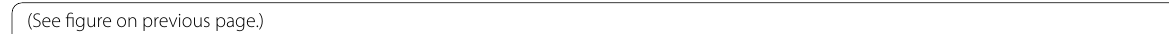
Fig. 7 p53 participated in ROCK1-mediated lens epithelial cells apoptosis in response to H 2 O 2 treatment. a Western blotting confirmation of the siRNA-mediated p53 knockdown. Cells were lysed for western blotting after transfection with si-p53 and si-NC, respectively. β-actin was used as an internal reference. Data are based on three independent experiments. The 40–70 kDa blot was retained by horizontal shear and incubated with a p53 antibody. The 35–50 kDa blot was retained by horizontal shear and incubated with the β-actin antibody. b The knockdown of p53 resisted the decreased cell survival index after ROCK1 over-expression. Cells transfected with the pcDNA-ROCK1 and si-p53 and were tested by the MTT assay. **p < 0.01 versus the pcDNA-NC and si-NC group. ## p < 0.01 versus pcDNA-ROCK1 and si-NC group, (n 3). c The knockdown of p53 resisted the = increase in apoptotic cells after ROCK1 over-expression. The apoptosis detection of LECs after transfection with pcDNA-ROCK1 and si-p53. Scale bar: 50 µm. d The apoptosis rates, which were calculated based on at least 100 cells from three experiments, **p < 0.01 versus the pcDNA-NC and si-NC group. ## p < 0.01 versus pcDNA-ROCK1 and si-NC group. e Western blotting indicated that knockdown of p53 suppressed the increase in